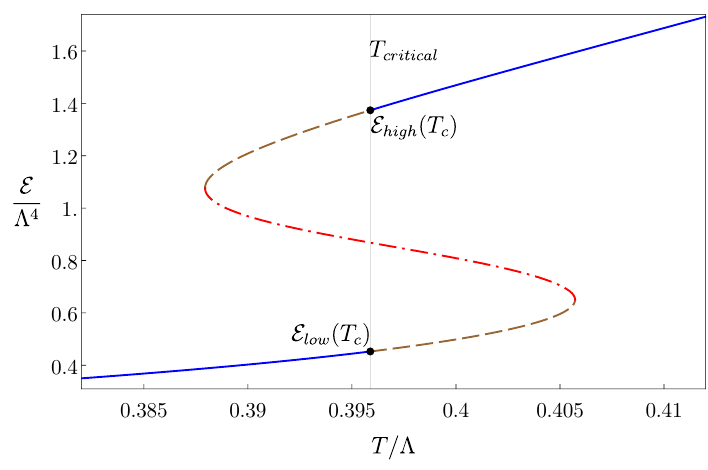
Figure 1 . Energy as a function of temperature for the theory considered in this paper, with intrinsic scale Λ . Stable, metastable and unstable states are represented by solid, dashed and dot- dashed curves, respectively. The vertical grey line corresponds to the phase transition temperature.